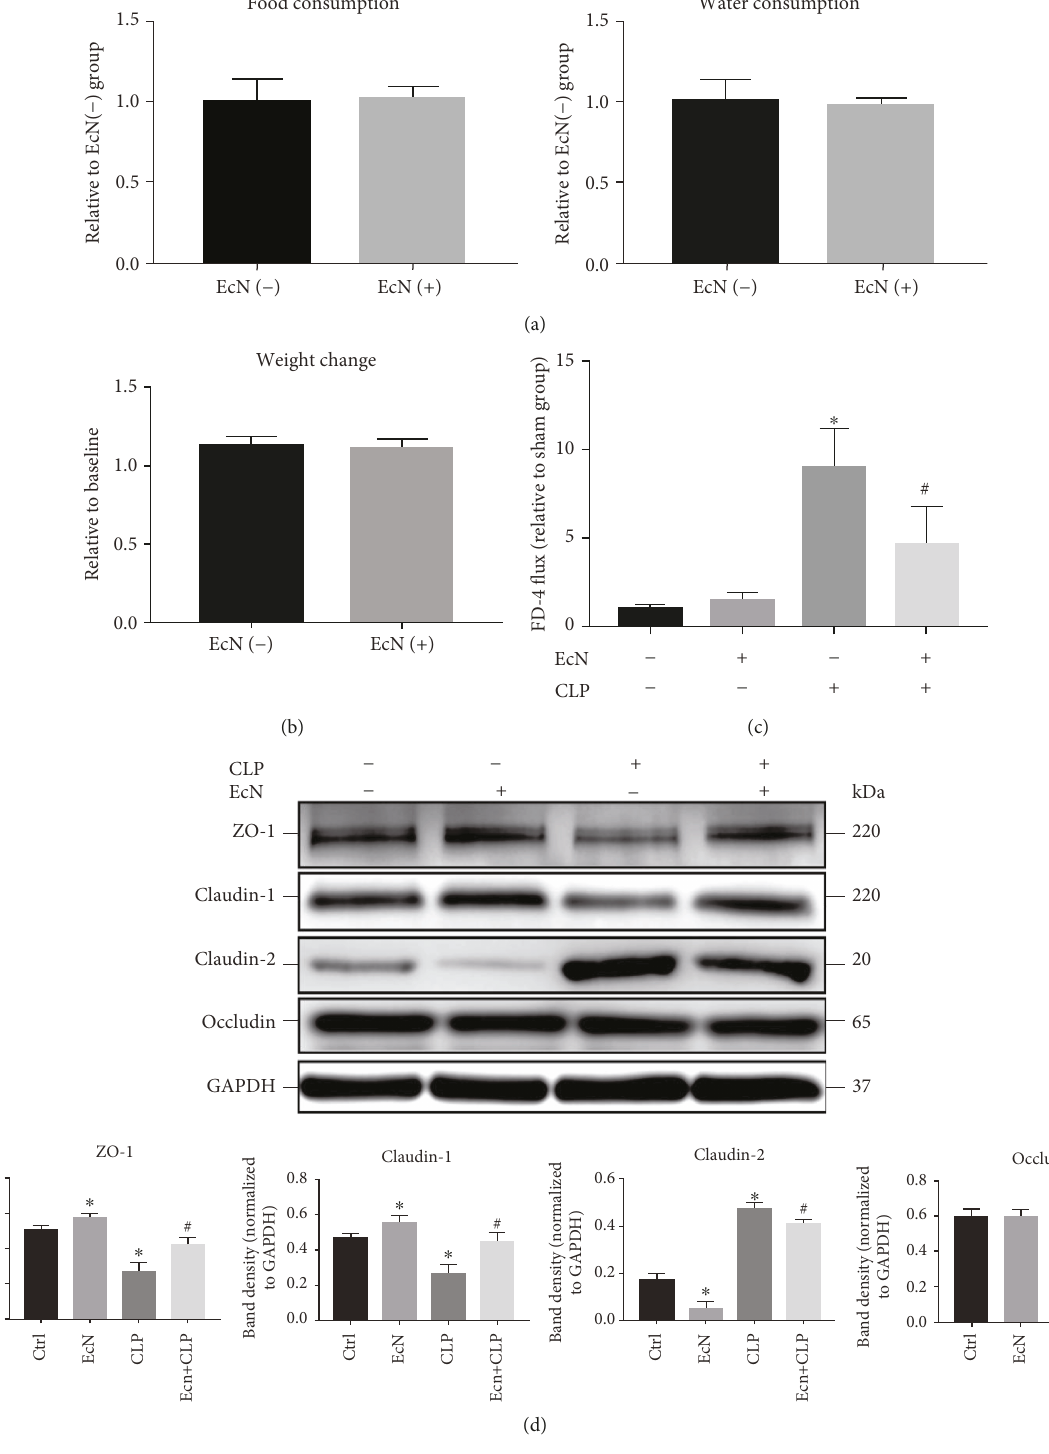
Figure 1: The e ff ect of EcN on mice with sepsis induced by CLP operation. (a) Food and water consumptions during the 14 days of oral gavage with saline or EcN ( 1 × 10 9 CFU/day ). (b) The weight of mice after 14 days of oral gavage with saline or EcN ( 1 × 10 9 CFU/day ). (c) FD-4 fl ux at 24 h after sham operation or CLP operation. (d) The mucosal cells of a mouse intestine were collected at 24 h after sham operation or CLP operation, and the total proteins were harvested followed by western blotting assays. Results were expressed as the mean ± SEM ( n = 10 ). ∗ P < 0 05 vs. the sham group. # P < 0 05 vs. the CLP